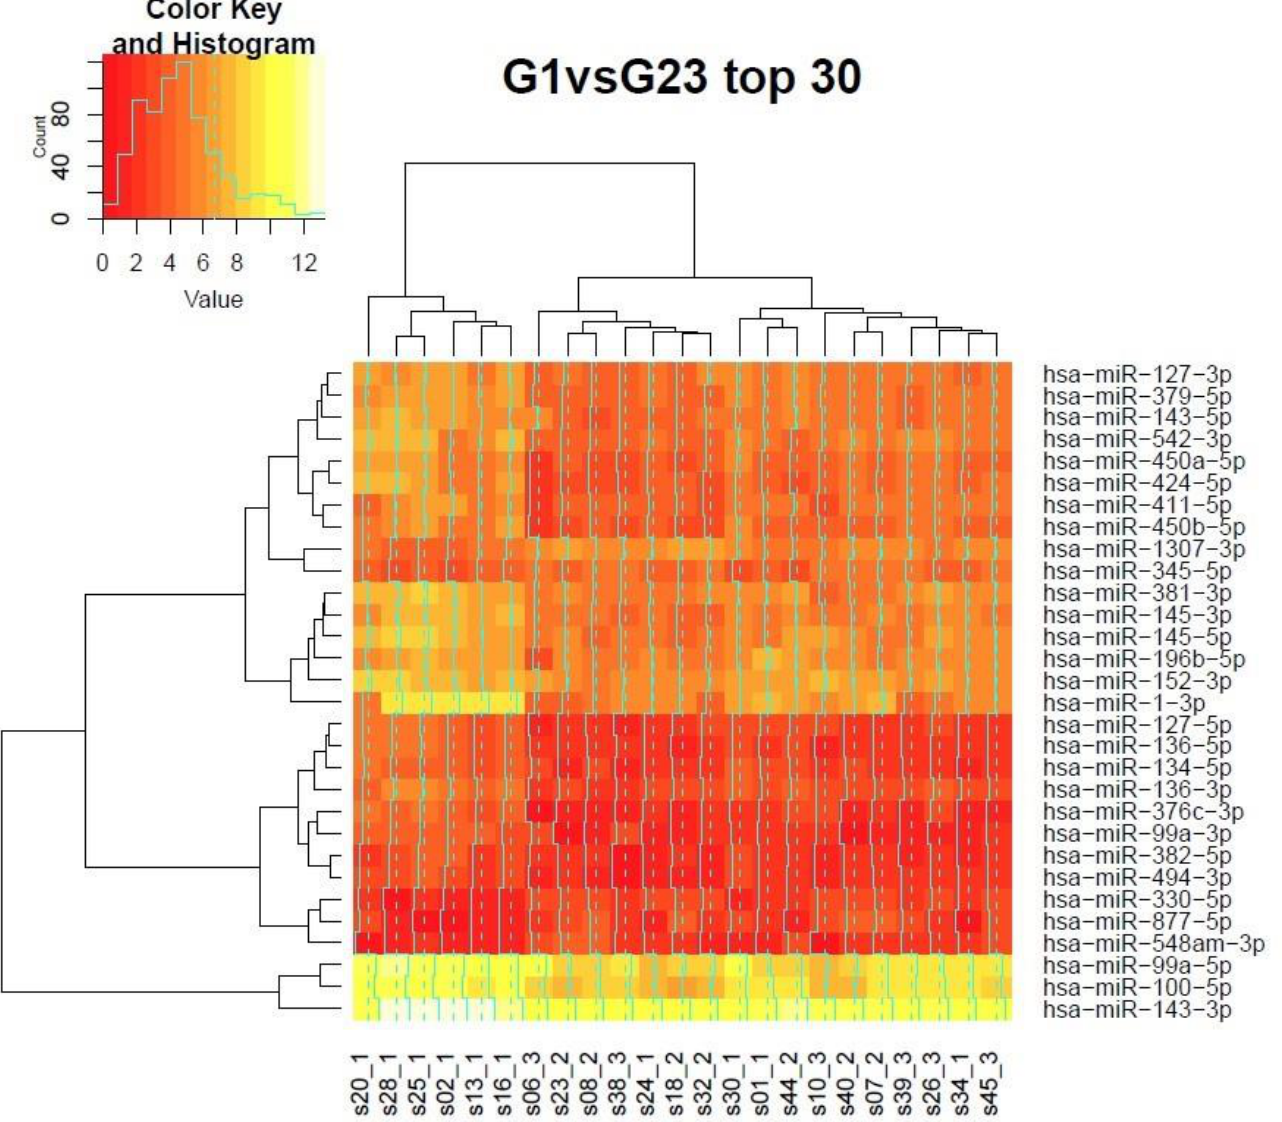
Figure 3. Clustering of the top 30 differentially expressed miRNAs of G1 patients vs. collected-together patients with G2 and G3 grade. Value = miRNA gene reads. At the bottom of the picture is the sample’s name with grade indication.